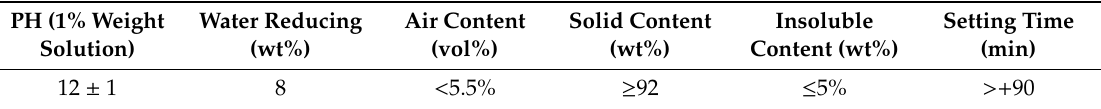
Table 6. Properties of the retarding water reducer. (Reproduced from the previous work [46] with permission from Elsevier).